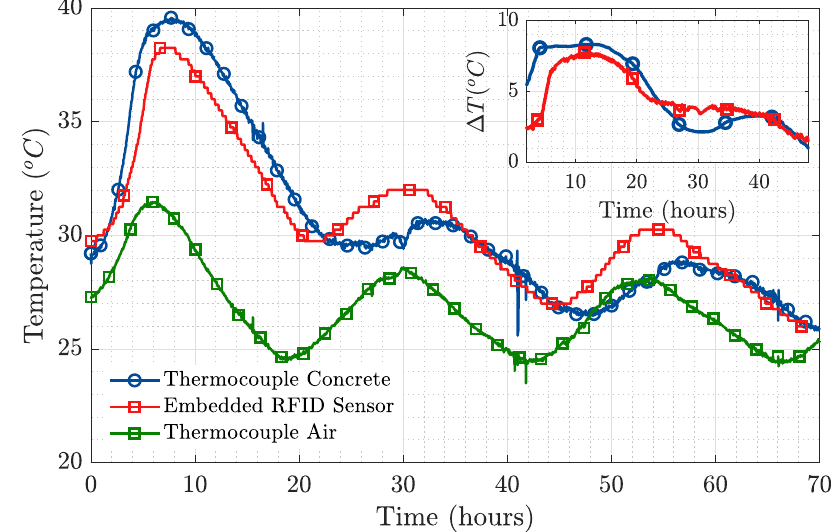
Figure 9. Main Figure: Temperature measured by the RFID sensor compared to temperature from the thermocouples. Top right Figure: Differential temperature inside concrete, removing the effect of room